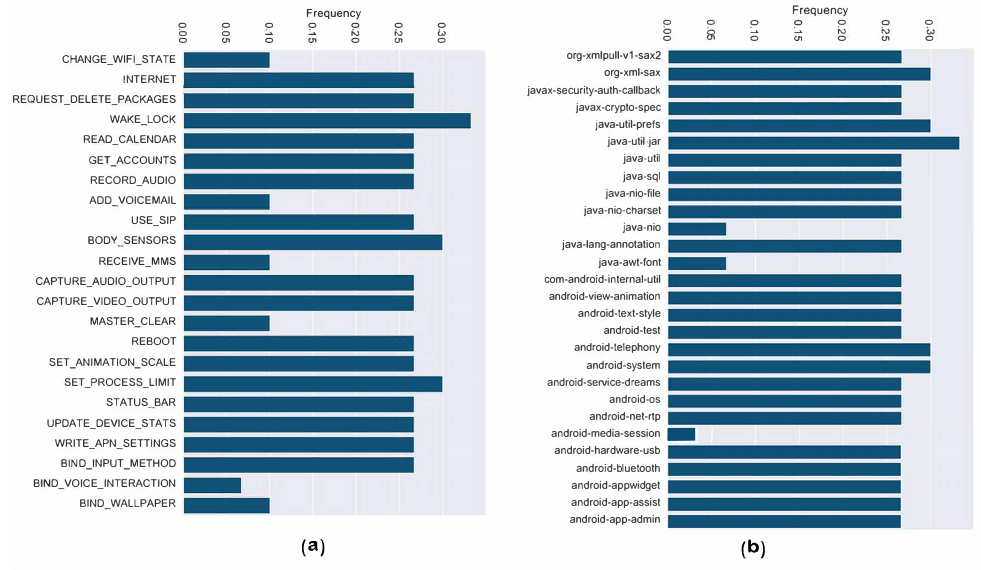
Figure 12. A representation of the most important features at SSA ( L = 50% ) , ( P = 50 ) . The reported features are attained when the importance ( > 0.25) and ( < 0.10). Sub-figure ( a ) shows the importance of the permission features, while sub-figure ( b ) depicts the importance of the API